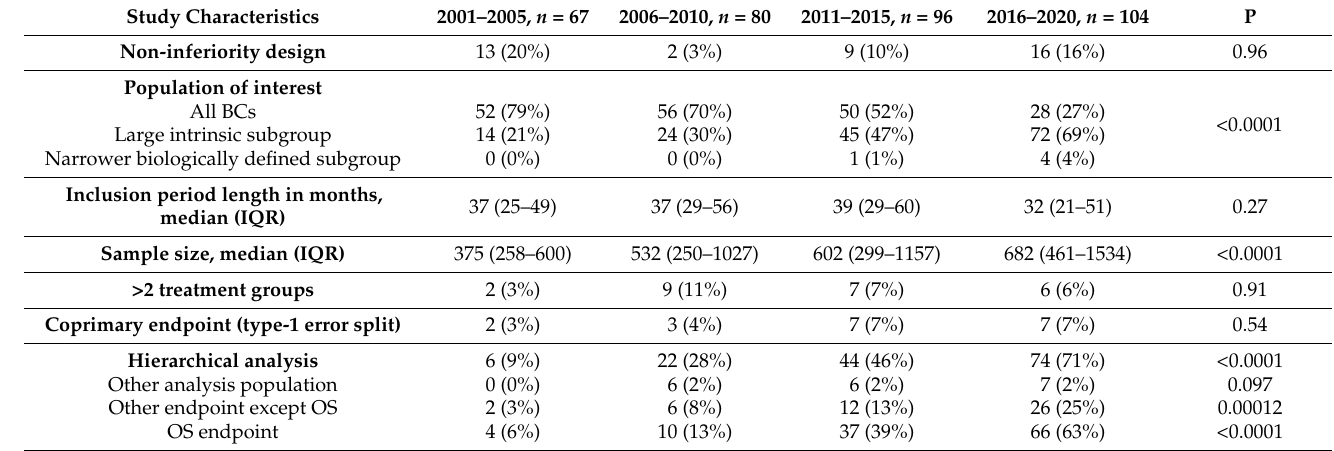
Table 2. Trial methods over time, all trials ( n = 347).